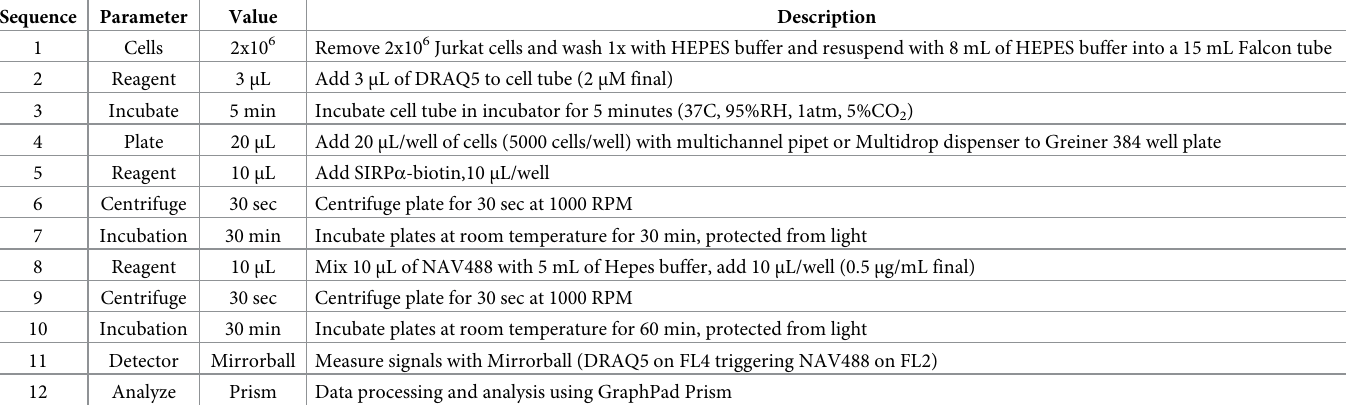
Table 1. Optimized LSC assay protocol.